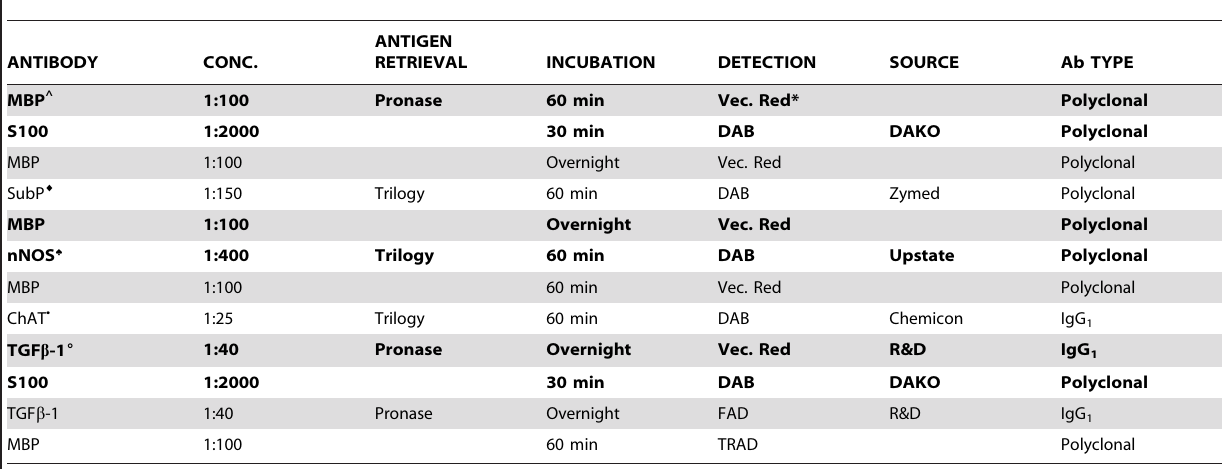
Table 1. Details of antibodies used in the